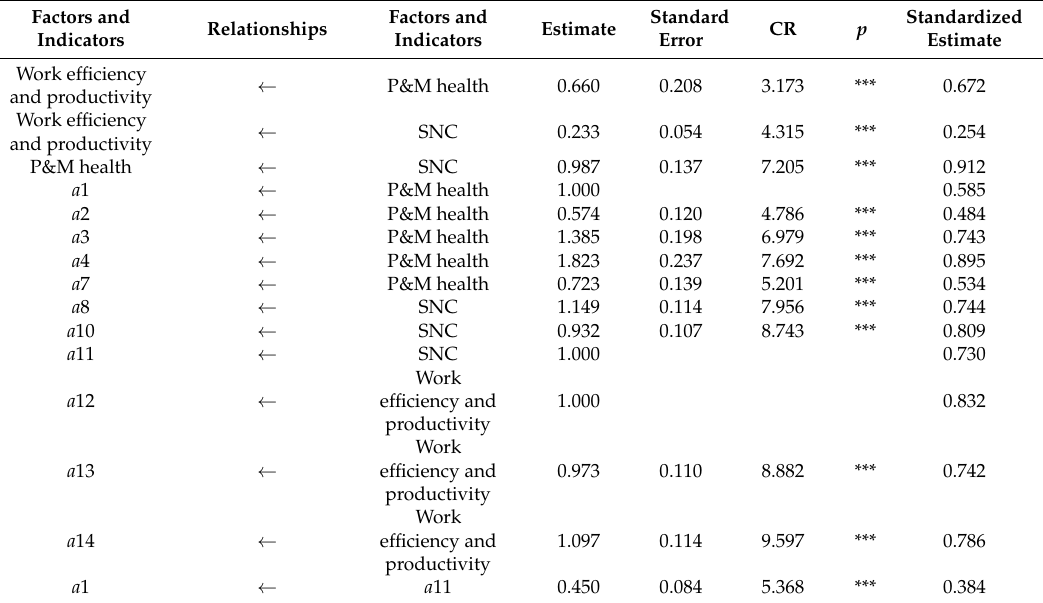
Table 6. Coefficient estimation of parameters in the improved